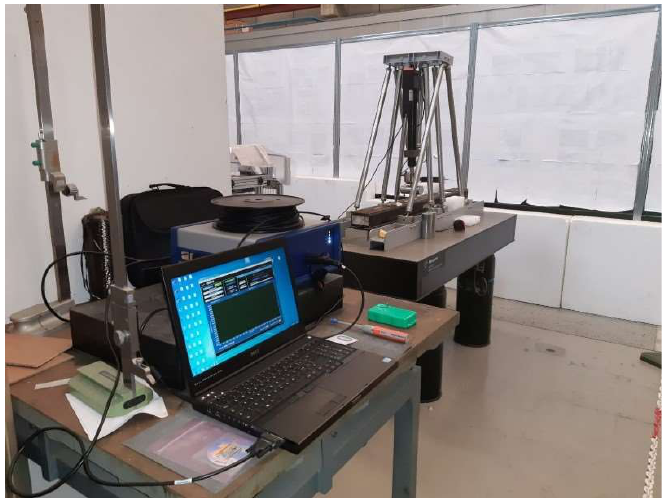
Figure 33. The composite beam with the indication of the implemented flaws.